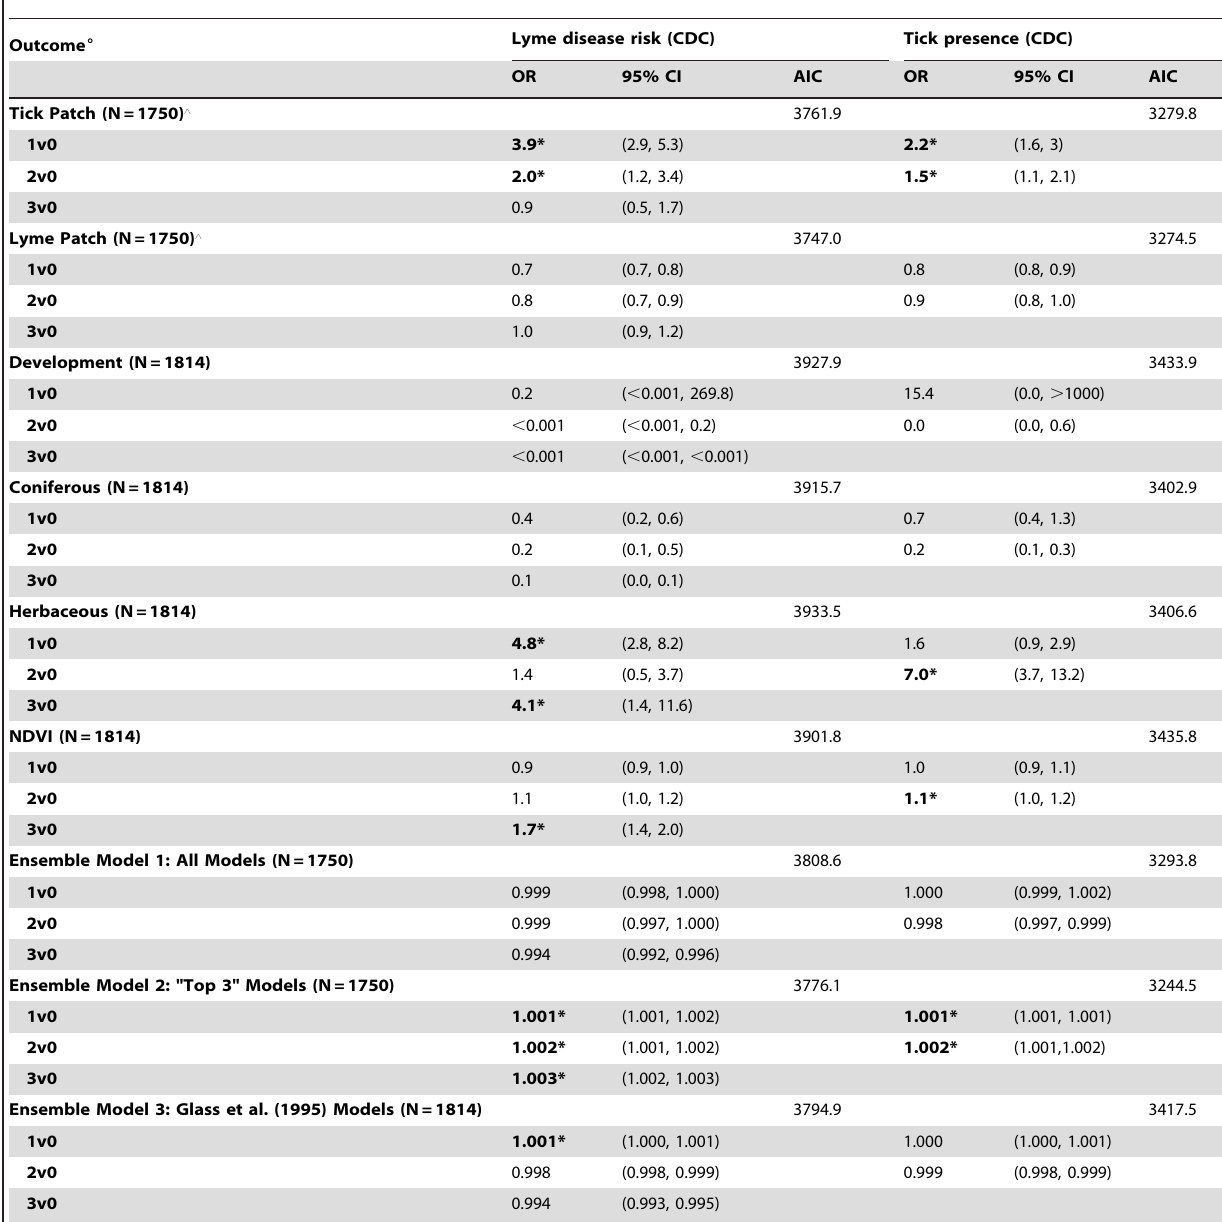
Table 6. Odds ratios in MLR for predictive models using CDC data as gold standard – original and ensemble models.